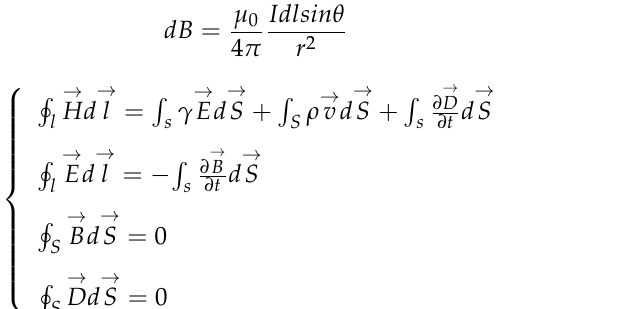
Figure 7. Schematic diagram of the new coil structure.